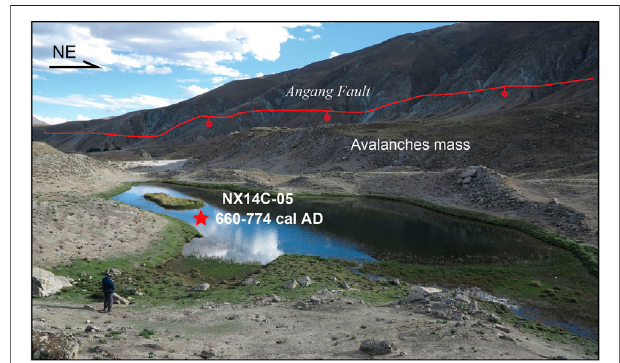
Figure 3 . In addition, according to our observations, the different textures in the images are not caused by the Xuqu River because there are no fl uvial sediments in the hummock of the landslide body. The elongated longitudinal ridges close to the source area indicate the high-velocity transport direction (Wang et al., 2019b). This region was restricted between the detached source area and the Xuqu River Valley (Wang et al., 2019).